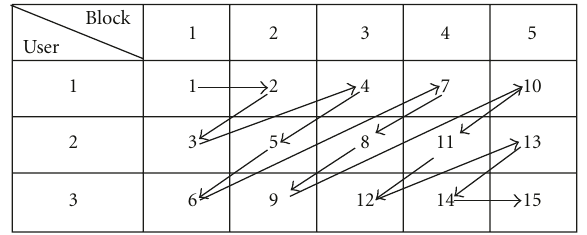
Figure 6: Order of detection for SIC.